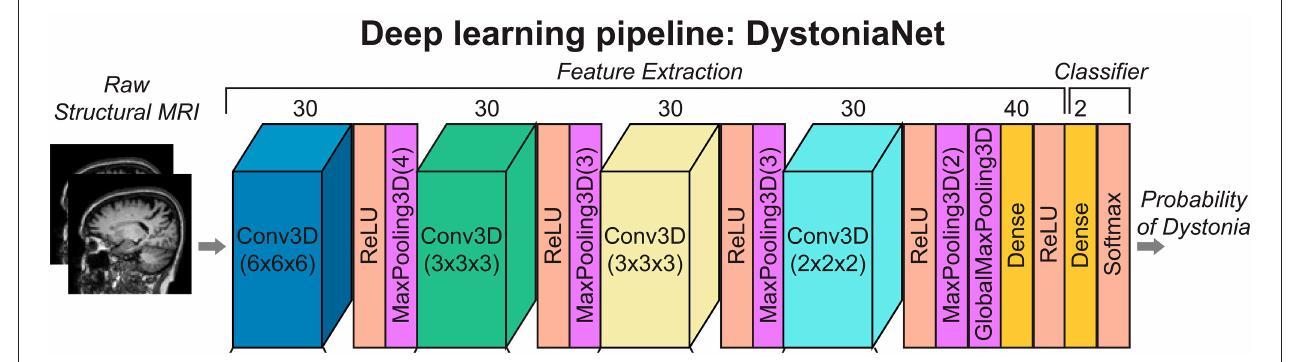
FIGURE 1 | Deep learning and shallow machine-learning pipelines for diagnosis of isolated dystonia. Raw structural brain MRIs were used with the deep learning pipeline (DystoniaNet). Copyright (2020) National Academy of